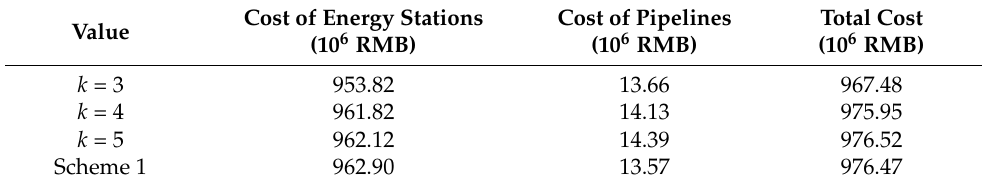
Table 2. Results under different k